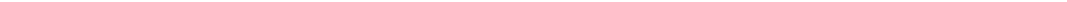
Figure 2: Modified Barcelona Clinic Liver Cancer (BCLC) staging system. Preserved liver function includes patients with Child-Pugh stage B up to seven points and no ascites. End-stage liver function are patients with >7 Child-Pugh points. Criteria for selection of patients for resec- tion are discussed in the text. For details regarding treatments see text. Treatment modalities shown in italics are currently not supported by high-level scientific evidence.MW = microwave ablation; RFA = radiofrequency ablation; SBRT = stereotactic body radiotherapy; SIRT = selec- tive internal